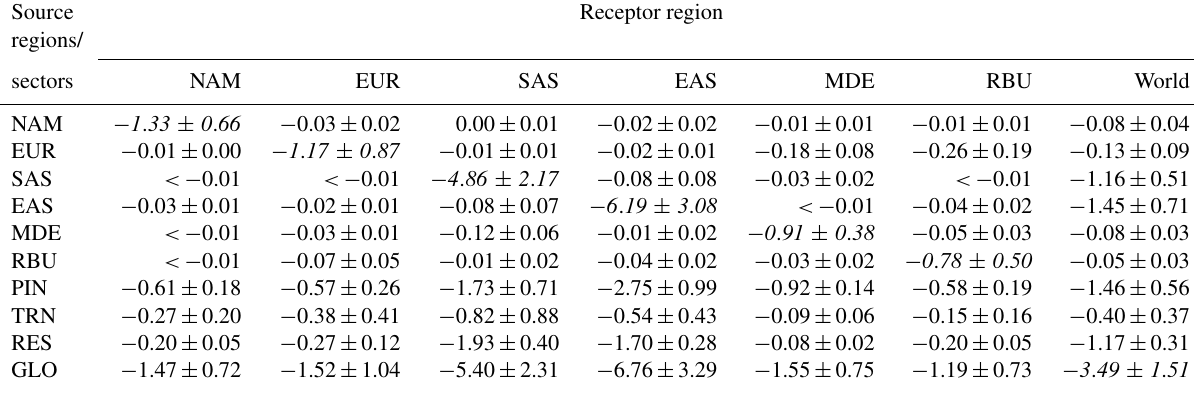
Table 3. Population-weighted multi-model annual average change in PM 2 . 5 concentrations (µgm − 3 ) in receptor regions due to 20% regional (NAM, EUR, SAS, MDE, and RBU), sectoral (PIN, TRN, and RES), and global (GLO) anthropogenic emission reductions. The diagonal, showing the effect of each region on itself, is shown in italics. All numbers are rounded to the nearest hundredth, and are shown with standard deviations among